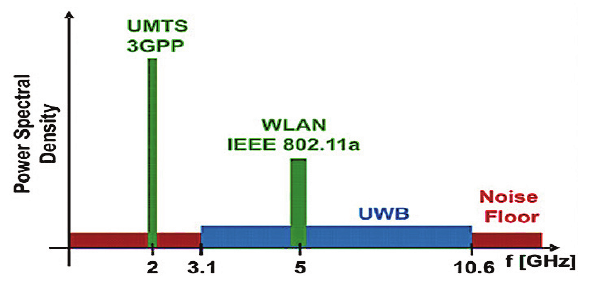
Fig. 1. Traditional radio signals power spectral density against the UWB